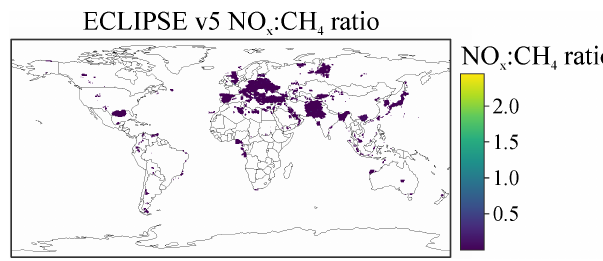
Figure D3. ECLIPSE v5 NO x : CH 4 ratio, at 0 . 5 ◦ × 0 . 5 ◦ for 2020 (Stohl et al.,